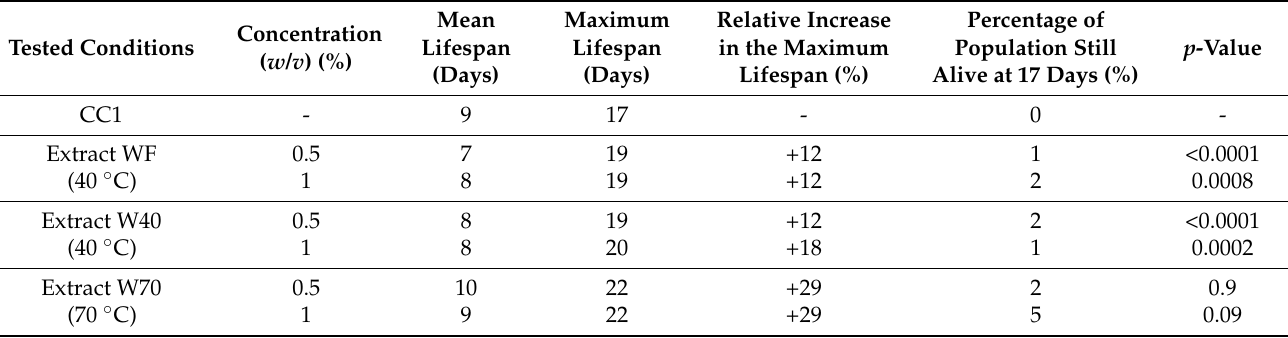
Table 4. Data of the longevity assay of the C. elegans GR1307 strain on the medium supplemented with the aqueous extracts WF, W40 and W70, and CC1 as a control. Mean lifespan, maximum lifespan and the percentage of population still alive were taken from the survival curves in Figure 3. p -values were calculated by comparing conditions with CC1 using the log-rank test.